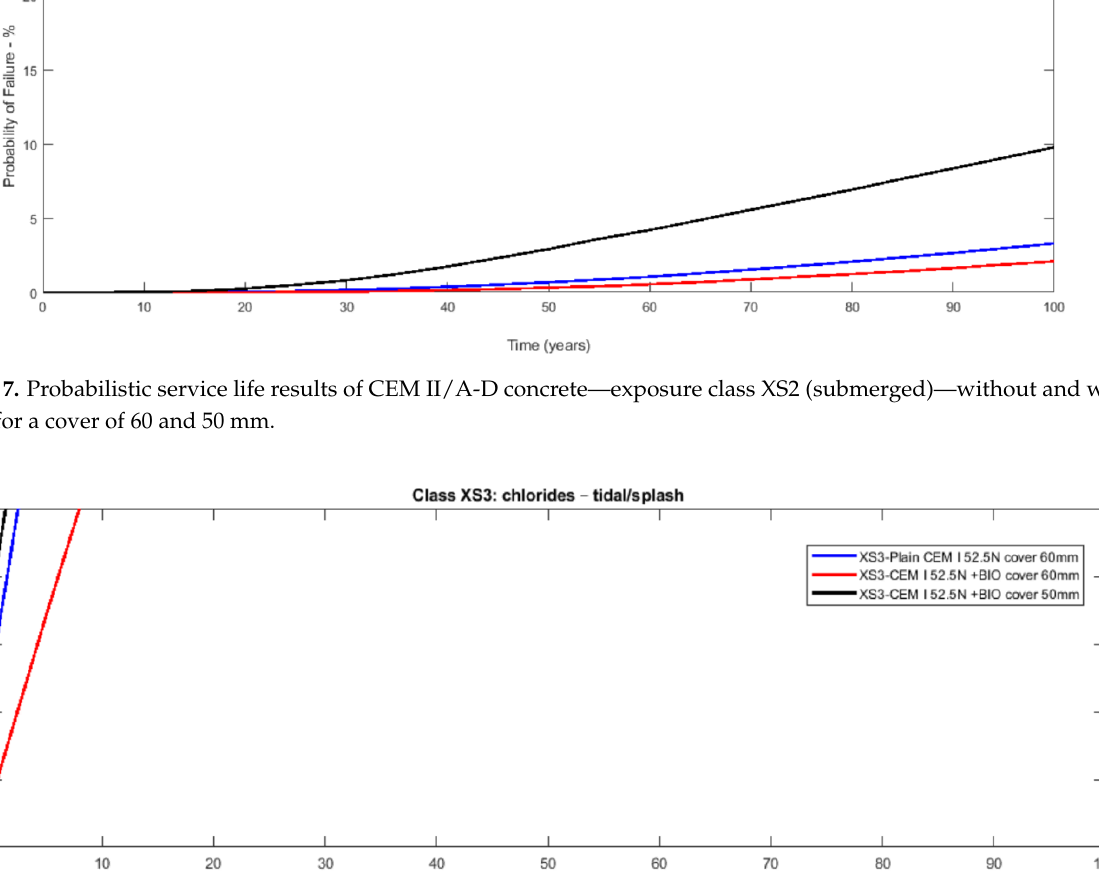
Figure 8. Probabilistic Service life results of CEM I 52.5N concrete — exposure class XS3 (tidal/splash) — without and with bioproduct for a cover of 60 and 50 mm.